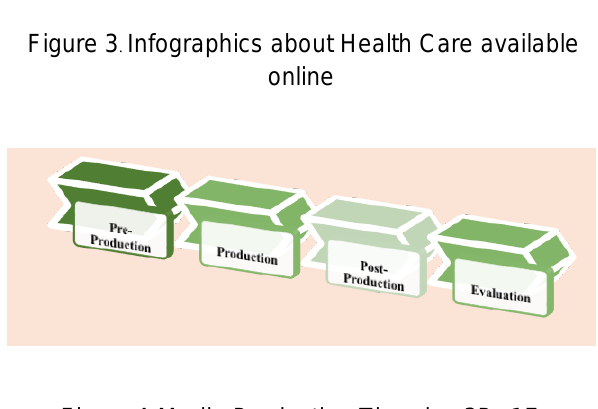
Figure 4 . Media Production Theories 3P + 1E